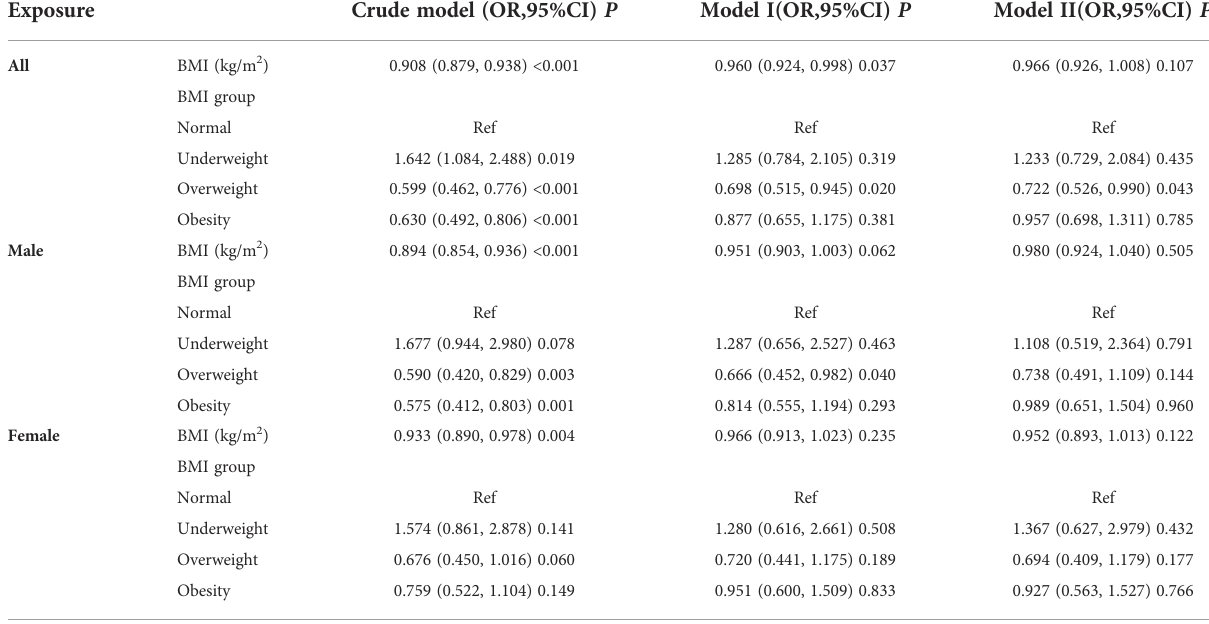
TABLE 3 Relationship between BMI and 3-month unfavorable outcomes in patients with acute ischemic stroke in different models. Exposure Crude model (OR,95%CI) P